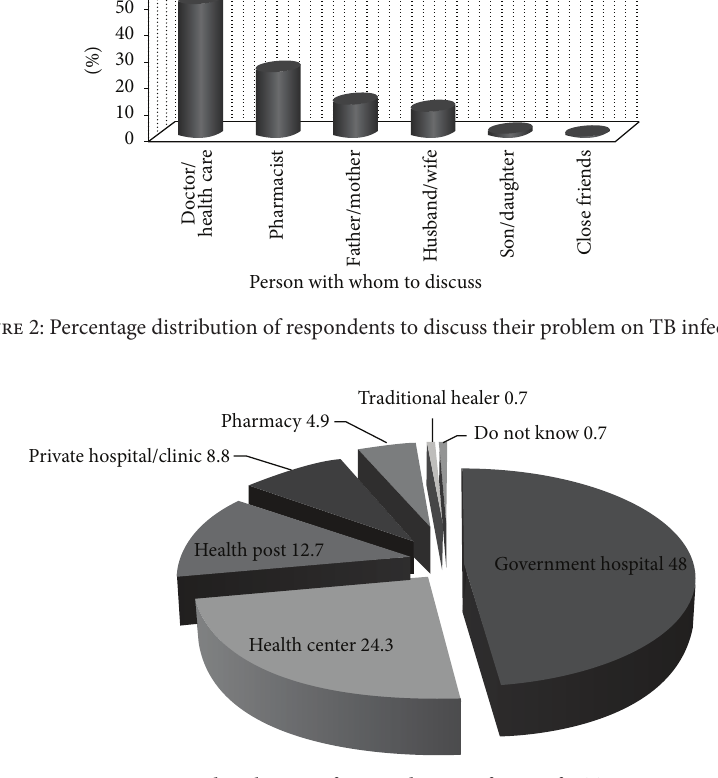
Figure 3: Percentage distribution of respondents preference for TB